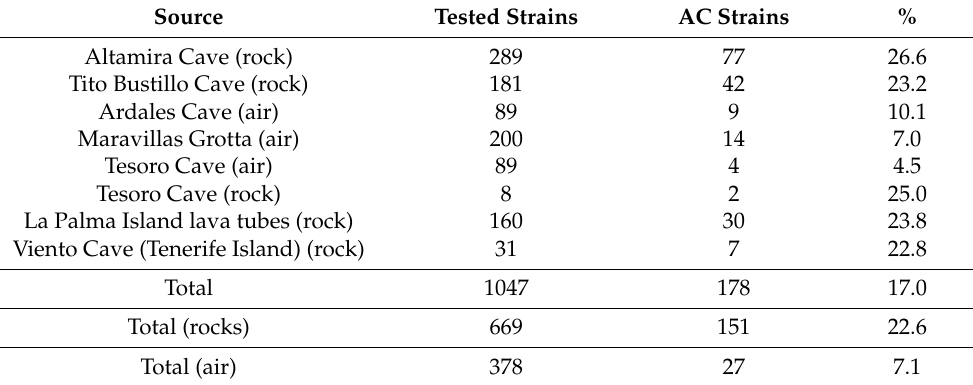
Table 1. Cave bacteria producing antimicrobial compounds (AC) against pathogenic bacteria. Source Tested